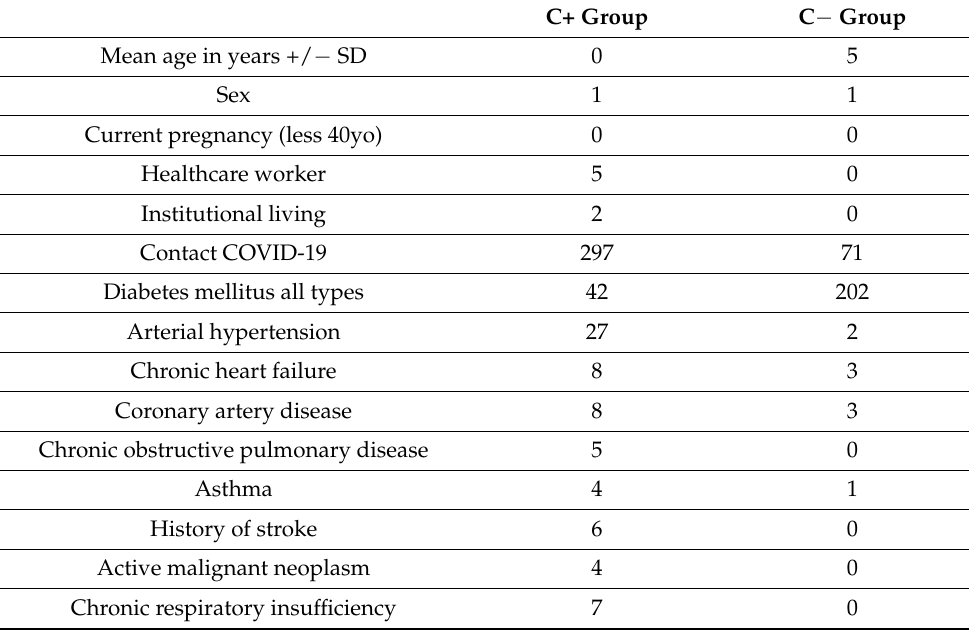
Table A1. Description of missing data by variable in Table